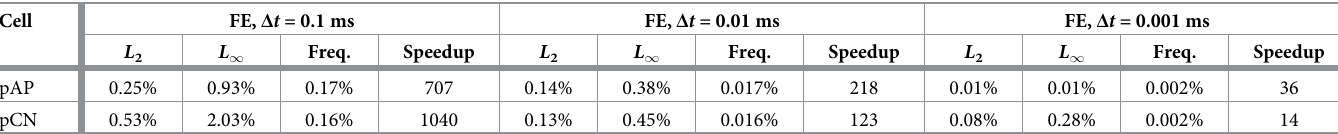
Table 4. Comparison of the accuracy of the results obtained with FE and BE methods at different time steps Δ t (Eq 14). Cell FE, Δ t = 0.1 ms FE, Δ t = 0.01 ms FE, Δ t = 0.001 ms L 2 L 1 Freq. Speedup L 2 L 1 Freq. pAP 0.25% pCN 0.53% 2.03% 0.16% 1040